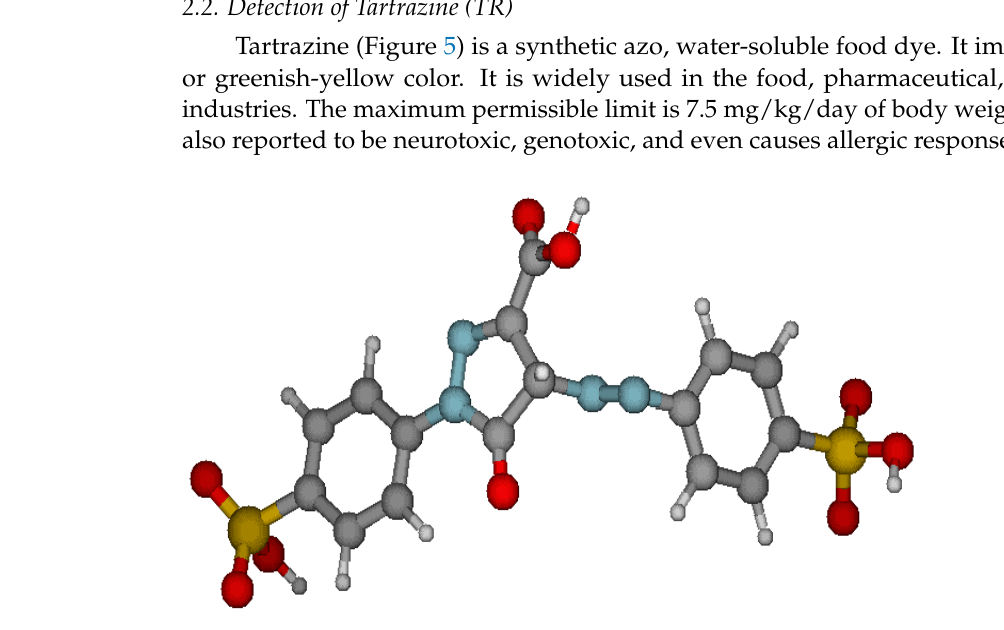
Figure 4. Cyclic voltammograms of (a) the ZnONF/CPE in pH 5.0 phosphate buffer solution (PBS) without SY; (b) the 40 µg/L SY in pH 5.0 PBS at the bare CPE, and (c) the ZnONF/CPE. Reprinted with the permission of Reference [24].